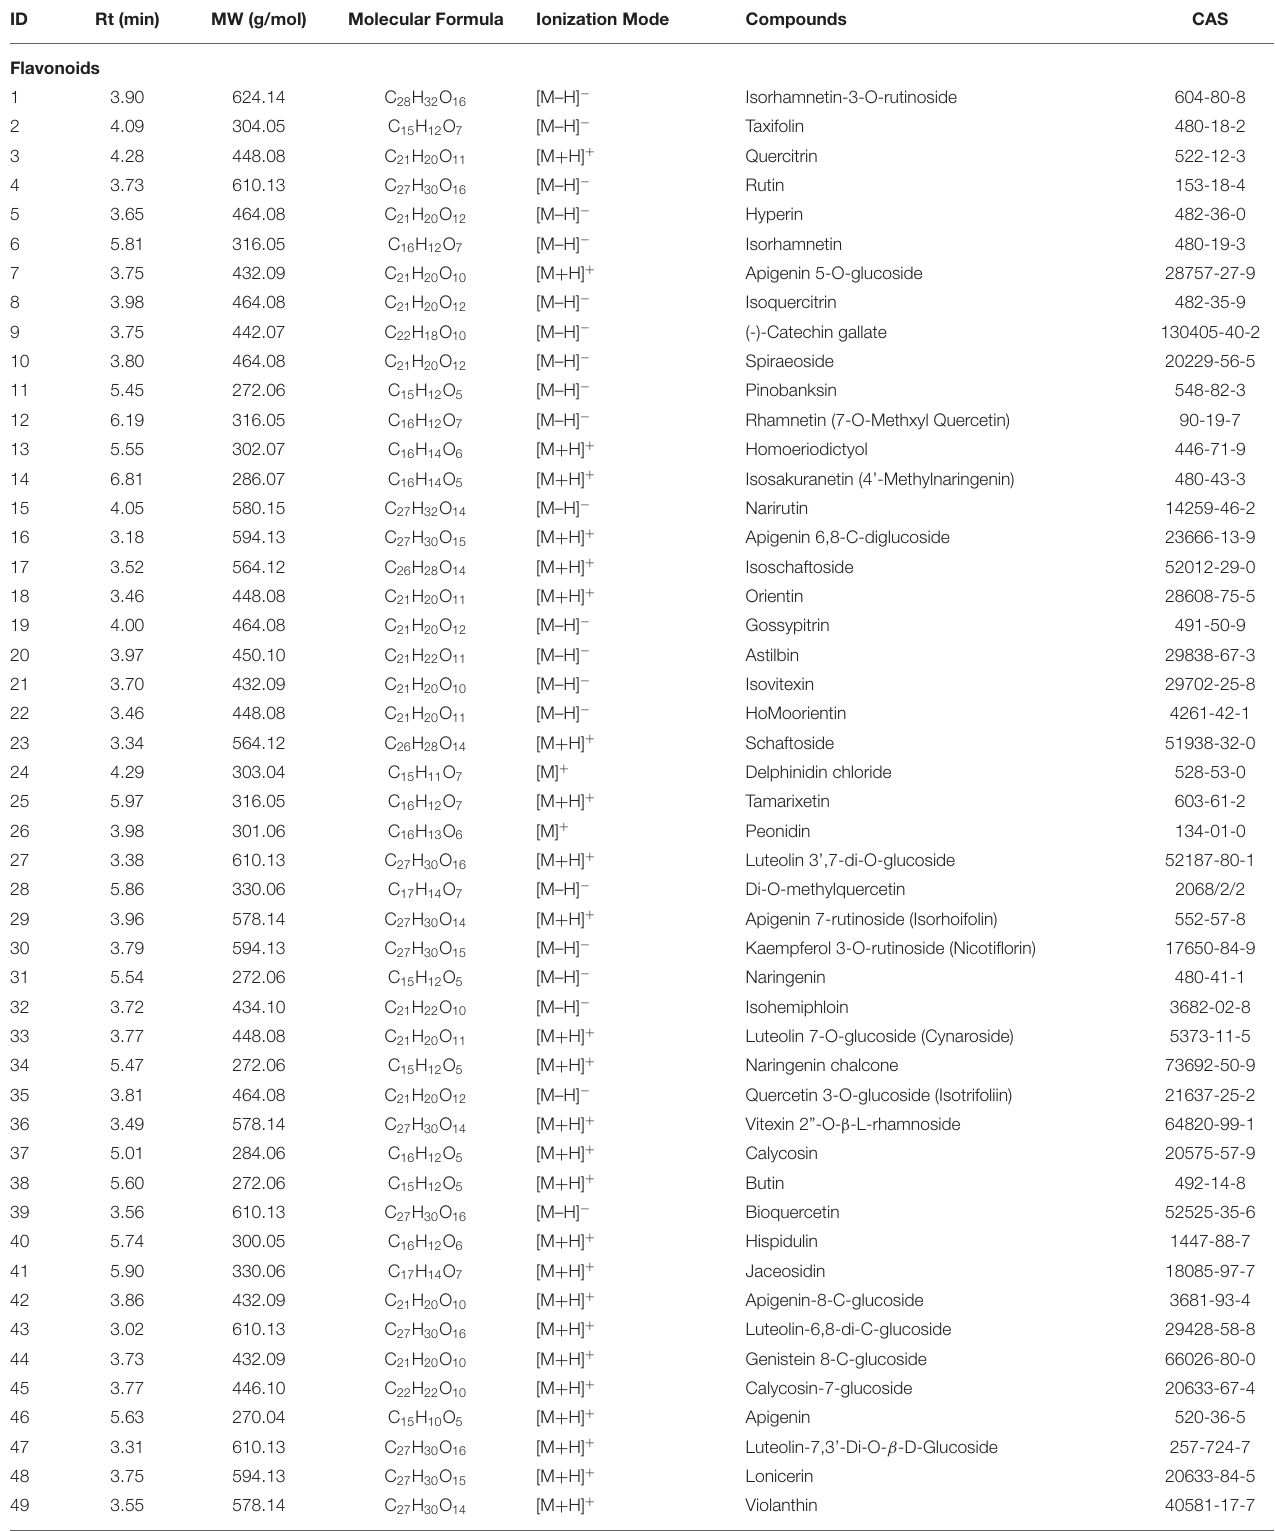
TABLE 1 | Component identification results of 70% methanol extracts from D. officinale